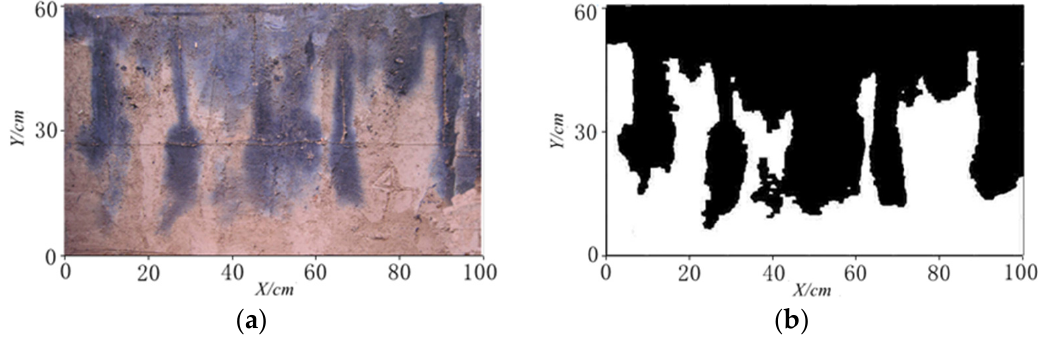
Figure 4. ( a ) The original image after correcting for lighting and geometric distortion; ( b ) a binary image after applying the dye detection algorithm.